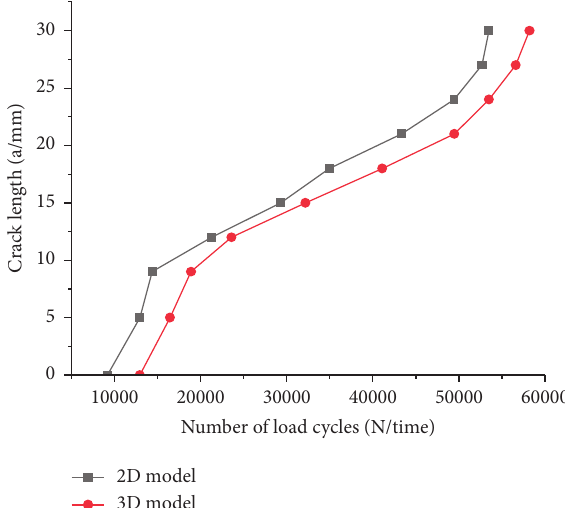
Figure 9: Crack propagation curves based on the high elastic stress. Absorption band treatment (without test